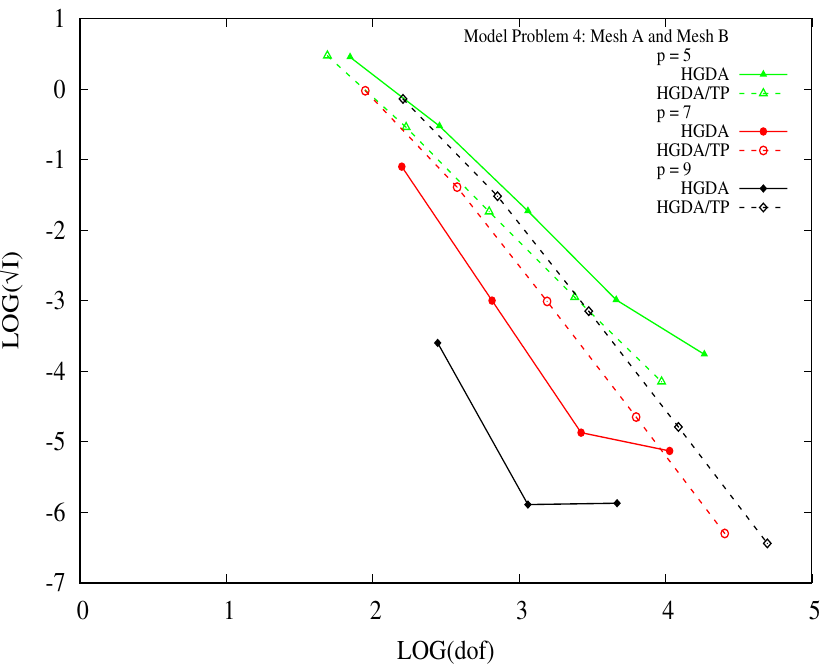
Figure 20. Residual function I versus dof, C 22 solutions: Model Problem 4 (Poisson’s Equation; Mesh B, HGDA/DG; Mesh A, HGDA/TP).